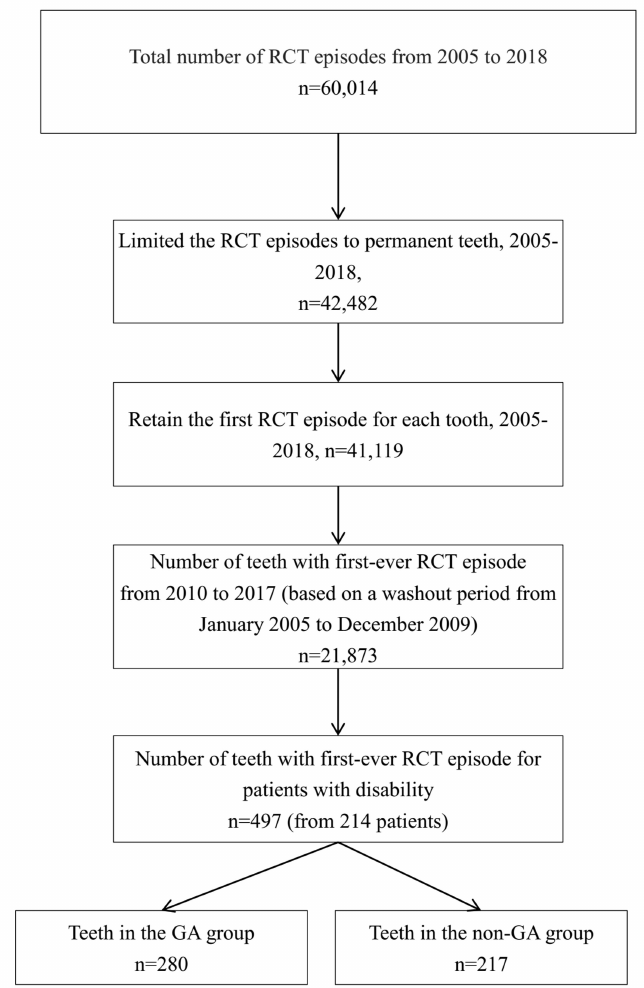
Figure 1. Diagram showing the selection of study sample population. GA, general anesthesia; RCT, root canal